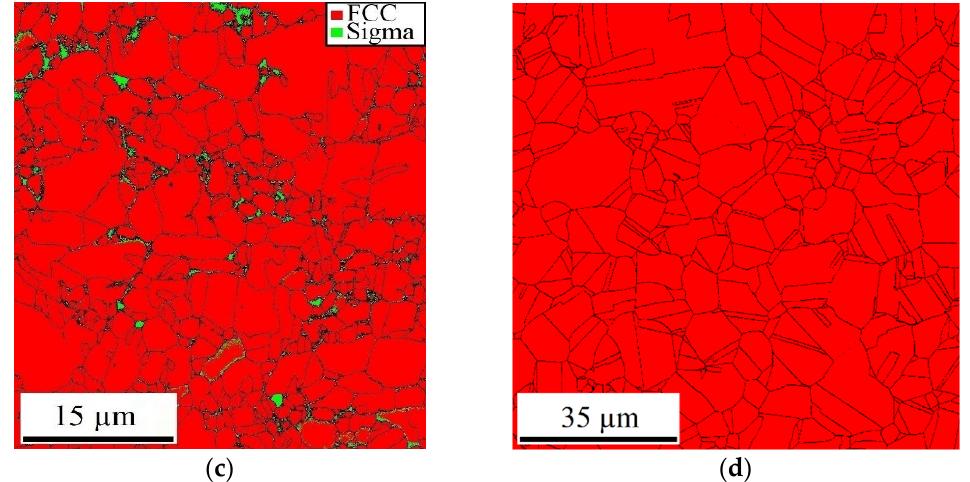
Figure 5. Microstructure of the N0.5 alloy after cold rolling and annealing at 700 °C ( a , c ) and 900 °C ( b , d ): SEM-BSE images—( a , b ), EBSD phase maps—( c , d ).